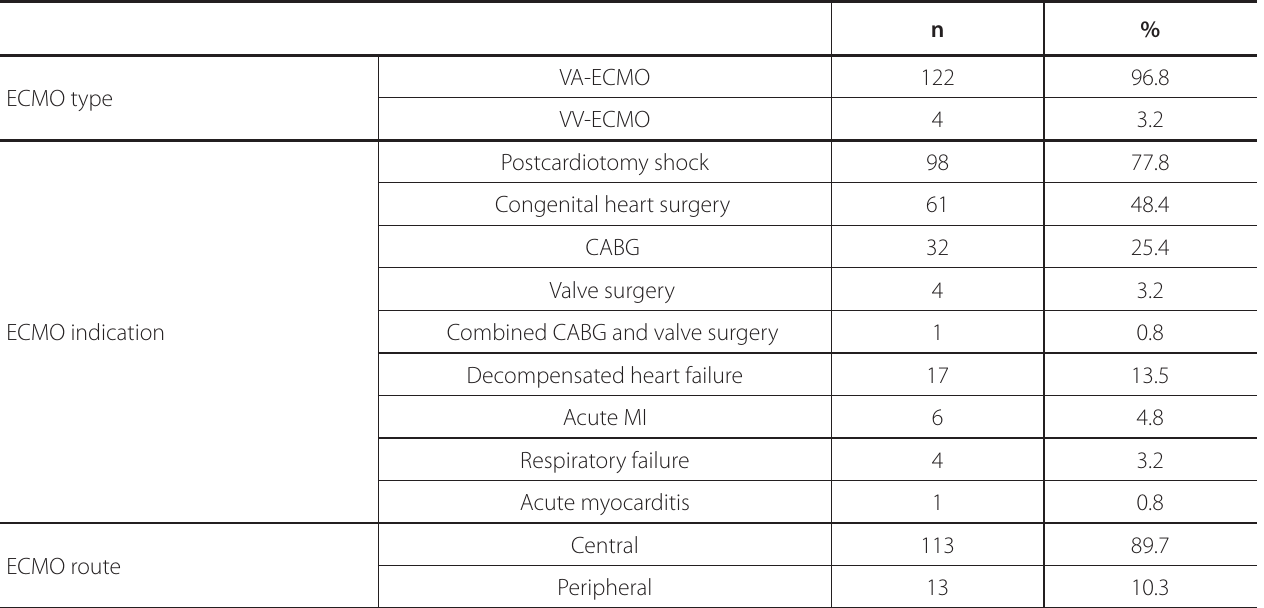
Table 2 . ECMO types, indications, and routes.